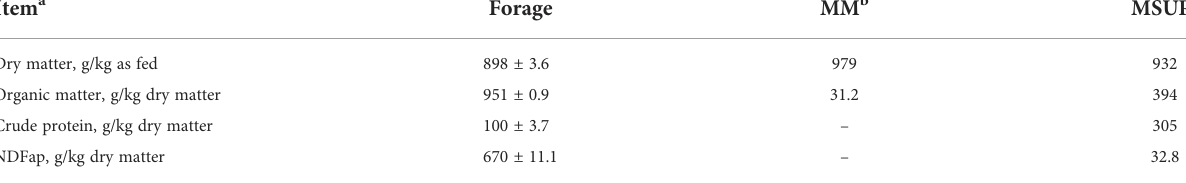
TABLE 1 Chemical composition of forage and